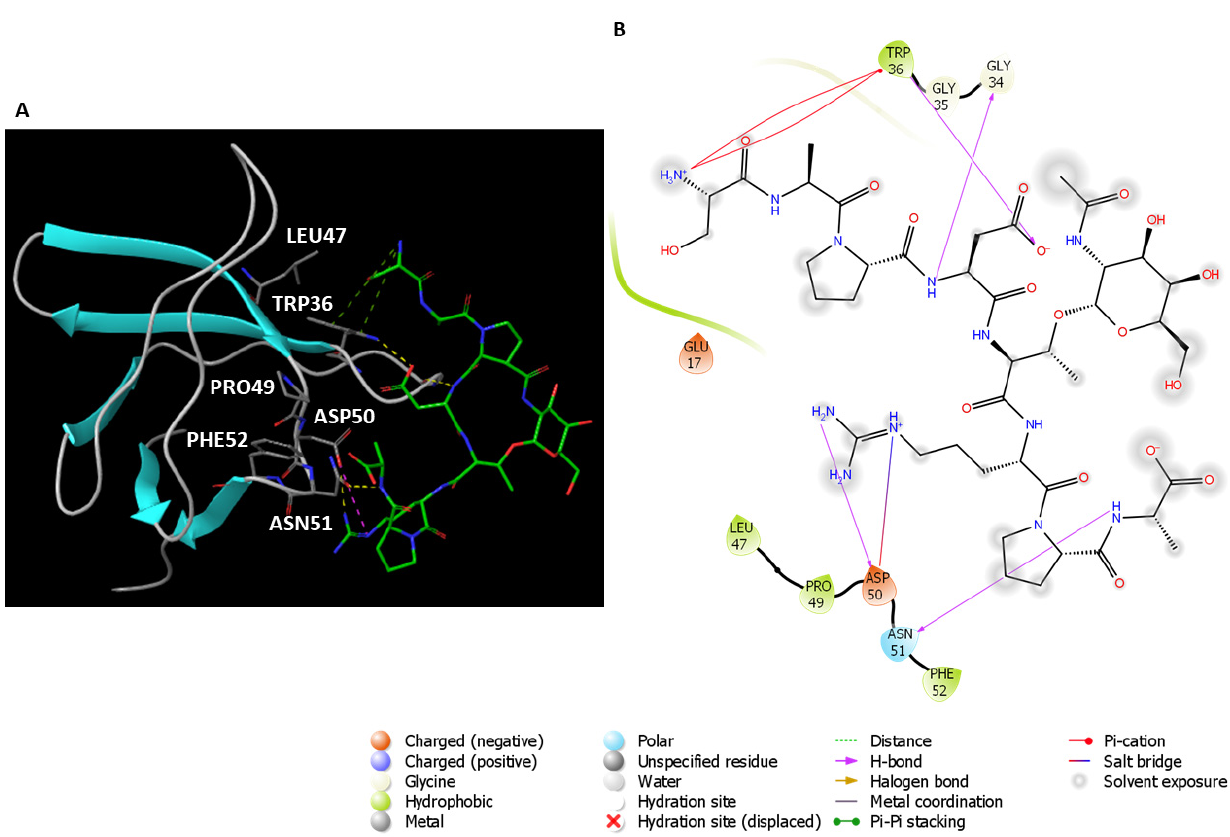
Figure 8. ( A ) Putative binding mode of MUC1 peptide on CIN85 SH3A domain. MUC1 peptide is displayed as green sticks. The amino acids residues of the binding site are represented as grey sticks. The different types of interactions are highlighted as colour coded dotted lines: H-bonds are represented in yellow, salt bridge in violet and π -cation in green. ( B ) 2D depiction of the peptide-protein interactions.